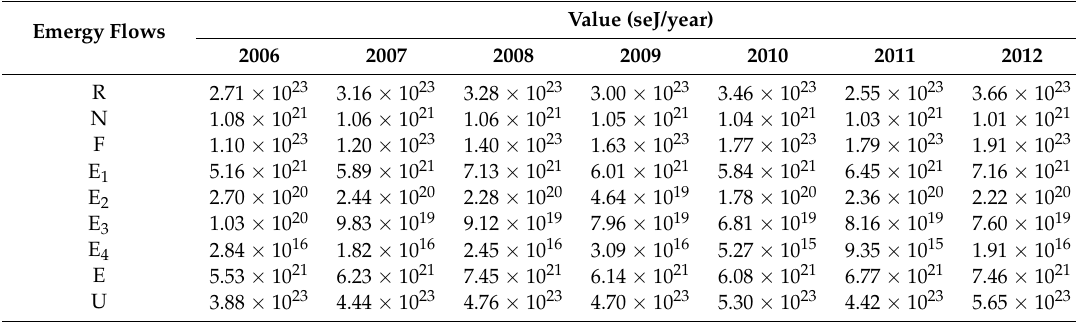
Table 5. Emergy flows calculated for Wuhan.